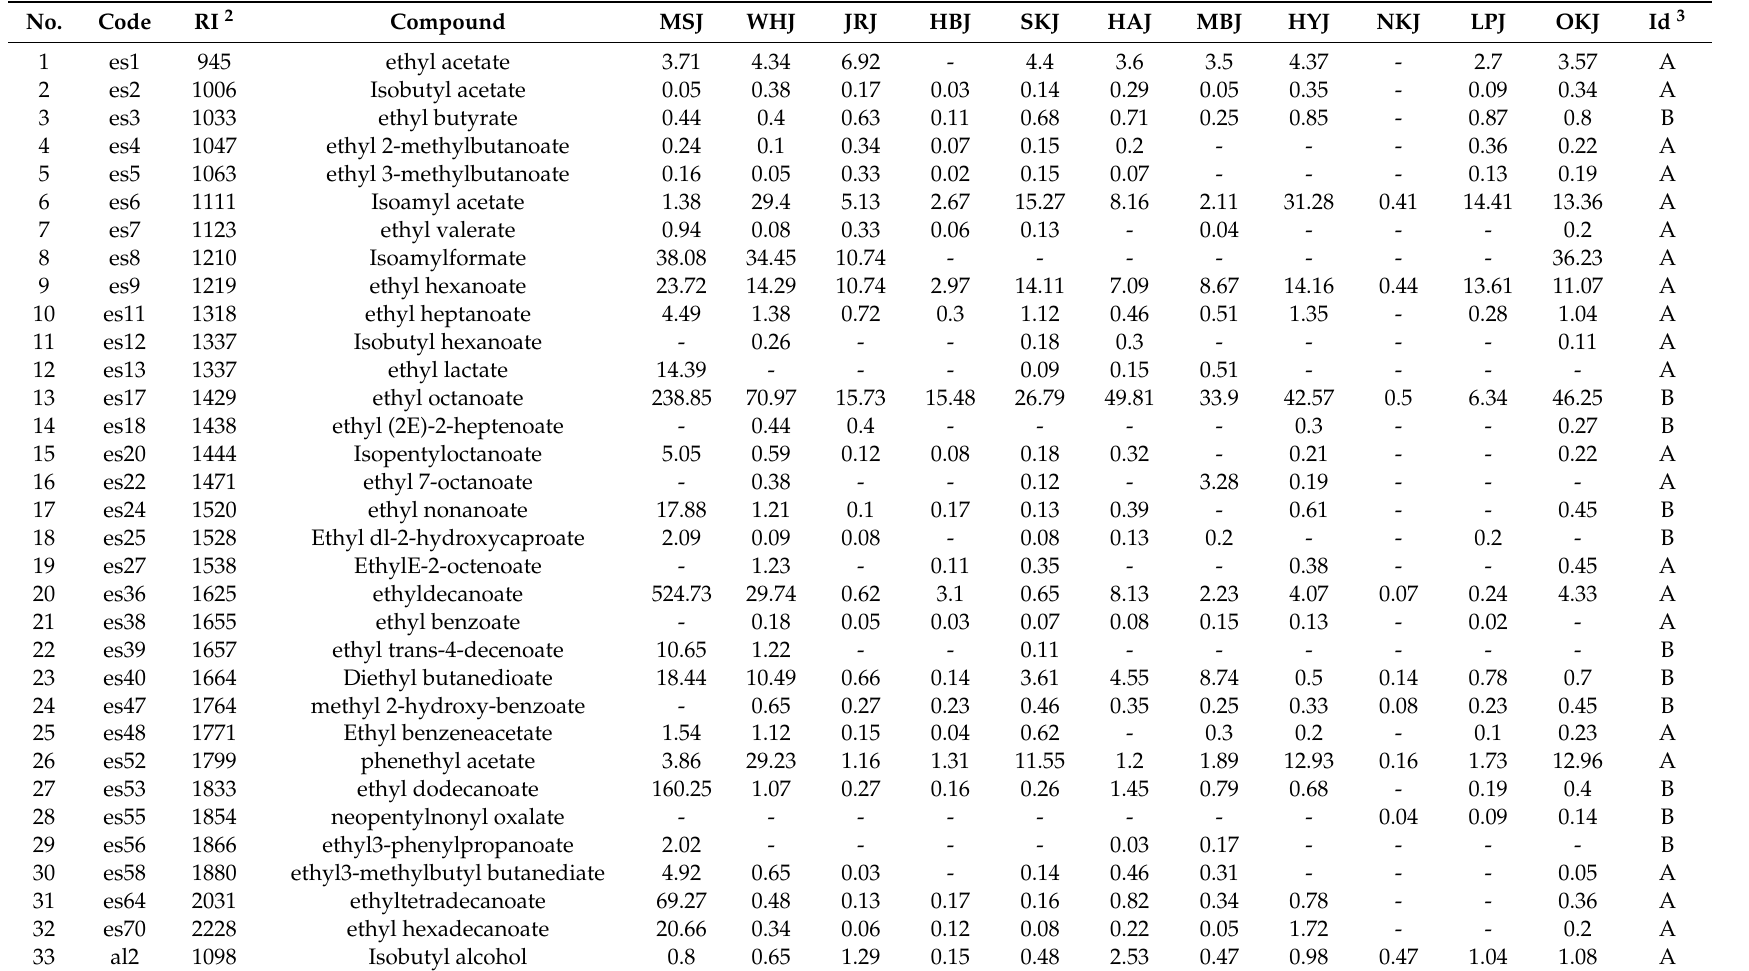
Table 3. Volatile components (mg / L) 1 in the commercially distilled soju